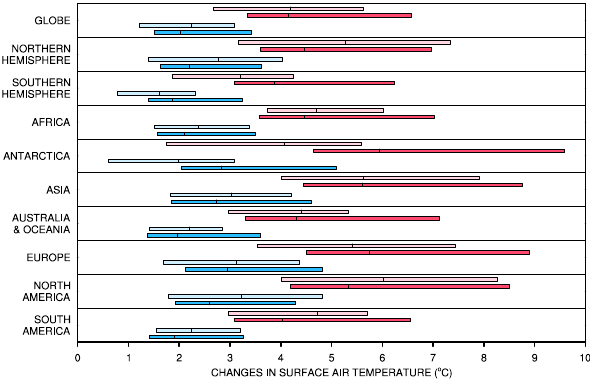
Fig. 19. Range of and median surface air temperature changes ( ◦ C) over the globe, each hemisphere and the seven continents for the period 2081–2100 relative to 1981–2000 simulated by the IGSM- CAM under the reference and level 2 stabilization scenarios and by 31 CMIP5 models under the RCP8.5 and RCP4.5. The reference scenario is shown in dark (light) red for the IGSM-CAM (CMIP5 models) and the stabilization scenario is shown in dark (light) blue for the IGSM-CAM (CMIP5 models). For the IGSM-CAM, the range is estimated as the minimum and maximum changes over the 30 simulations, while the median is estimated as the ensemble mean for the median climate sensitivity. For the CMIP5 models, the range is estimated as the 90% range amongst all the models (by removing the “outliers”), and the median is calculated based on all 31 models.